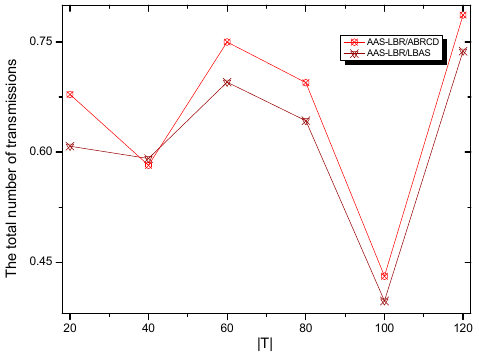
Figure 50. The impact of | T | with fixed network nodes = 800 with fixed on the total number of transmissions.